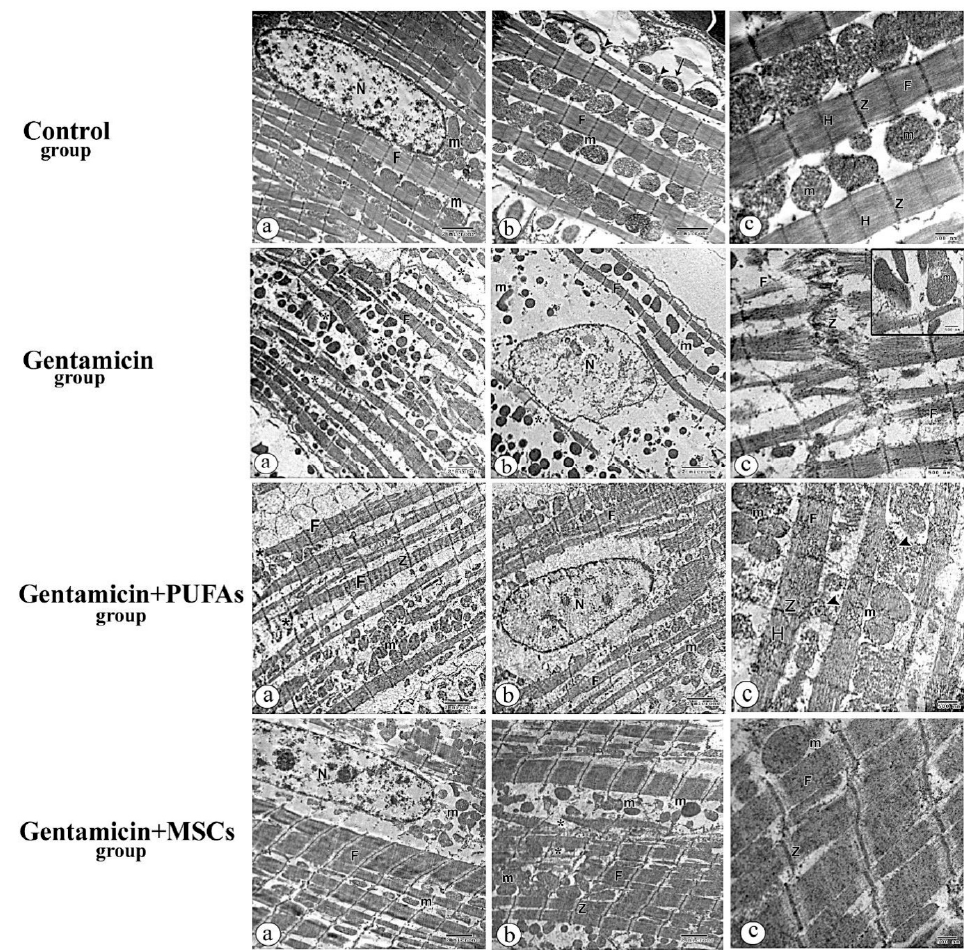
Figure 9. Electron micrographs of heart sections from rats of the control group: ( a ) centrally located nucleus (N), regular arrangement of the myofibrils (F), and mitochondria (m); ( b ) normal cell membrane of cardiac myocytes (arrow) with invaginations at T-tubules (arrow heads); ( c ) Z lines (Z) and H lines (H). Electron micrographs of heart sections from rats of the gentamycin-treated group: ( a , b ) separation of myofibrils with increased interfibrillar spaces (star) and myofibrillar fragmentation and degeneration ( F ) and irregular nucleus (N); ( c ) discontinuation and disarrangement of Z lines (Z), with disorganization of mitochondria (m in the incet); Electron micrographs of heart sections from rats of the gentamycin- and PUFA-treated group: ( a ) normal arrangement of myofibrils (F) with slight loss of myofibrils (star); ( b ) normal appearance of nucleus (N); ( c ) well-arranged mitochondria with some disorganization (arrow head) and continuation of Z lines (Z) and H lines (H) in some areas but not others (arrow). Electron micrographs of heart sections from rats of the gentamycin- and MSC-treated group: ( a ) normal arrangement of myofibrils (F) with a nearly normal nucleus (N); ( b ) mitochondria with a normal appearance regained (M); ( c ) continuation of Z lines (Z).